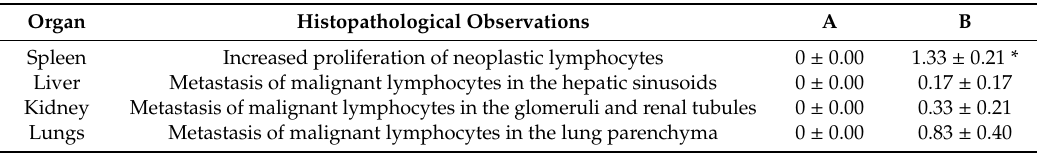
Table 4. Histological lesion scoring (mean ± SEM) for leukaemia in the spleen, liver, kidney and lung tissues of ENU treated mice, 12 weeks post inoculation.